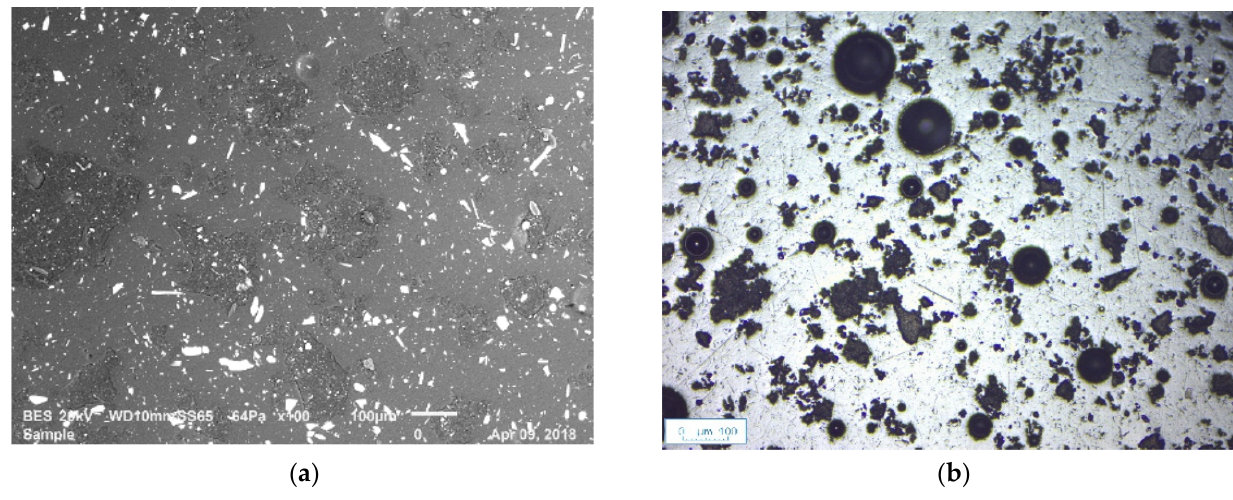
Figure 11. Microstructural observation of LR2AL10 by means of ( a ) SEM; ( b ) TLM [53]. Microstructural observation is maintained for LR2G1 and LR20 compositions as